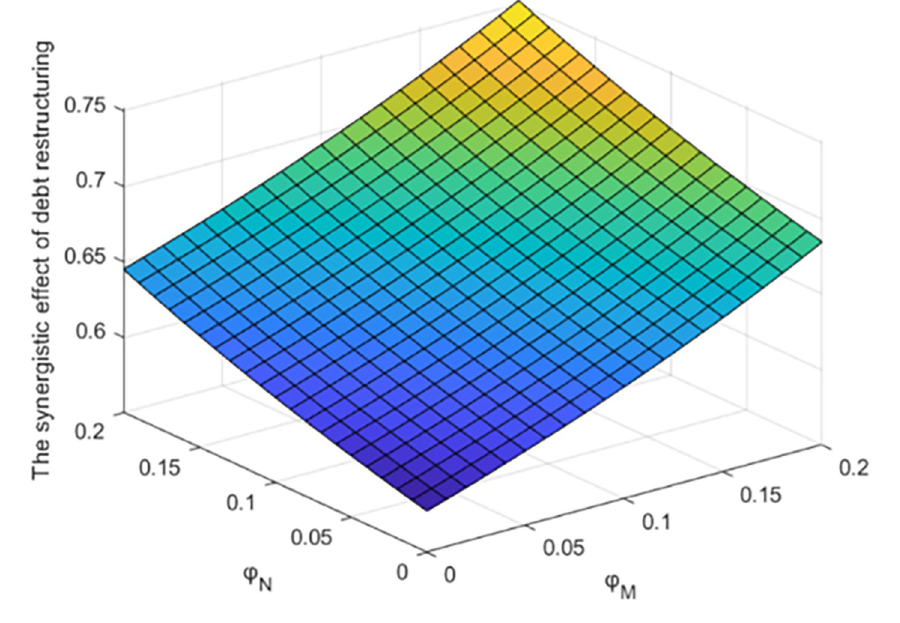
Fig 9. Effect of parameter φ